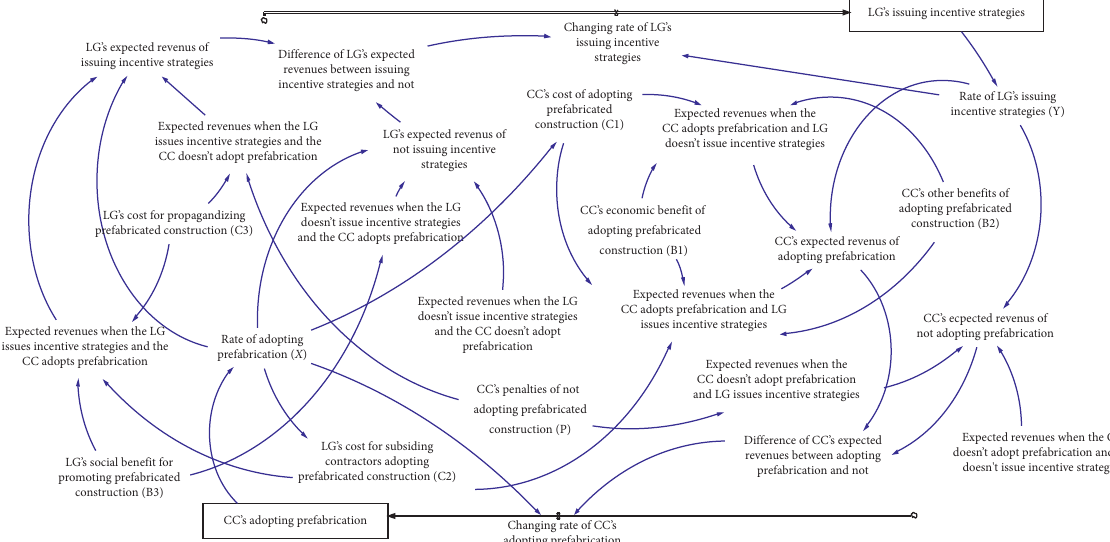
Figure 7: Modified SD model for dynamic incentive